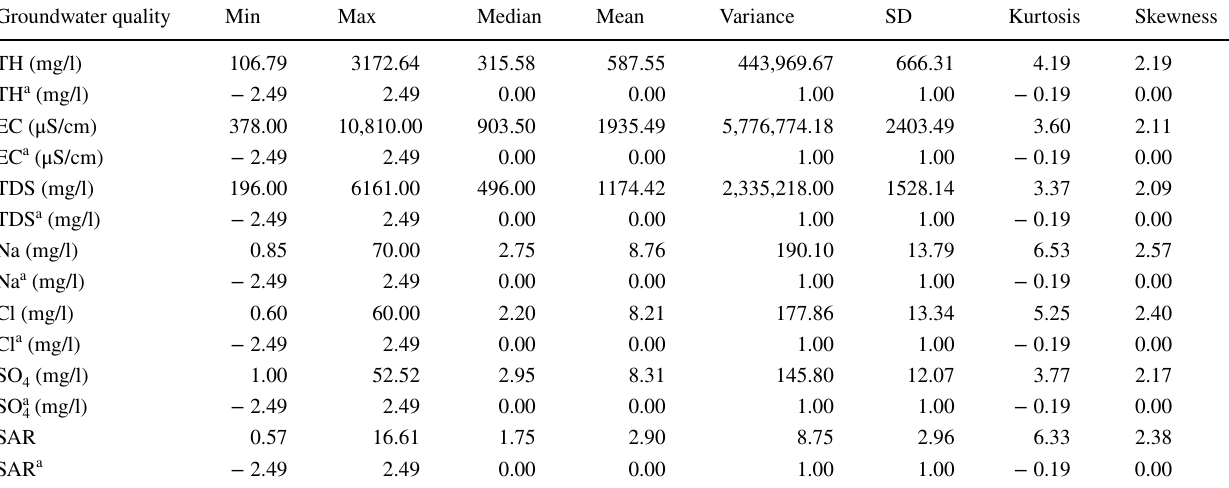
Table 1 Descriptive statistics of groundwater quality parameters